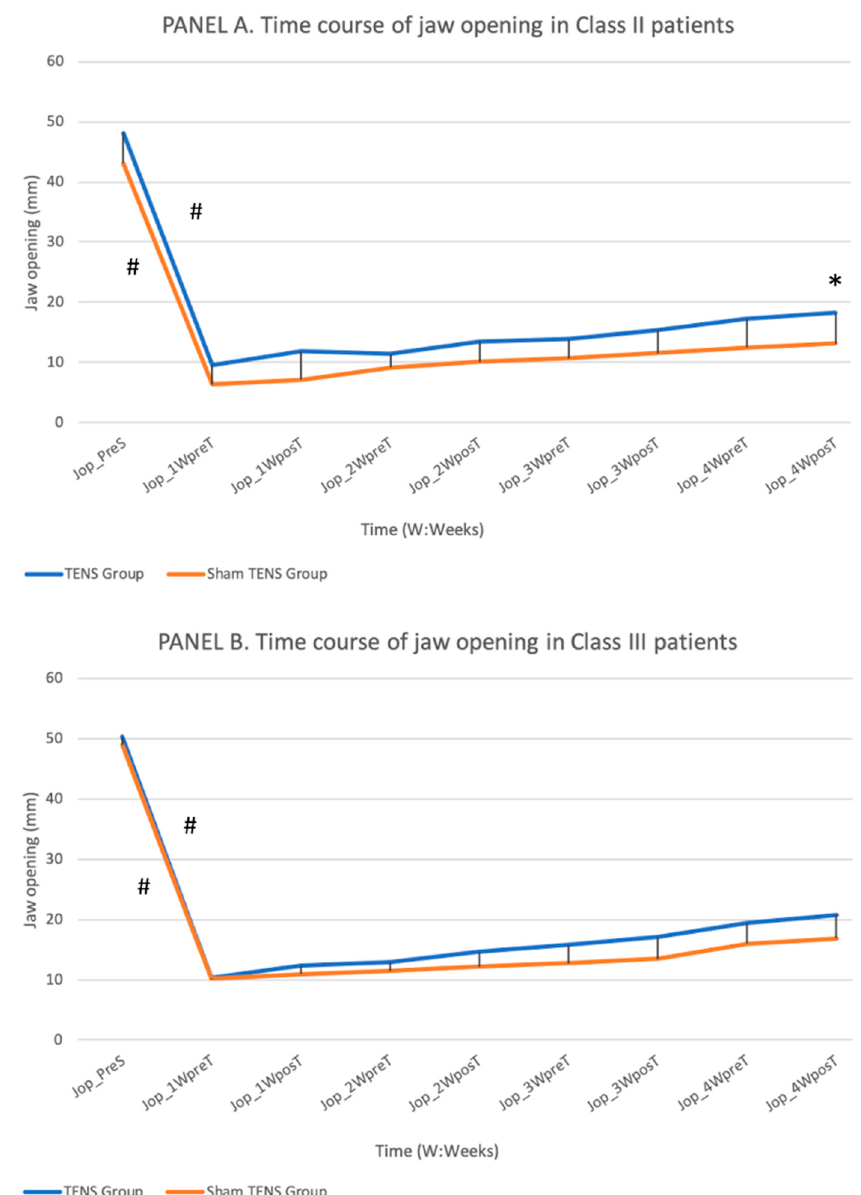
Figure 3. Depicts the time course of maximum jaw opening in the TENS and sham-TENS groups of class II ( A ) and class III ( B ) patients over the study period. ( # significant differences ( p < 0.05) between different time points in the same group, * significant differences ( p < 0.05) between groups).